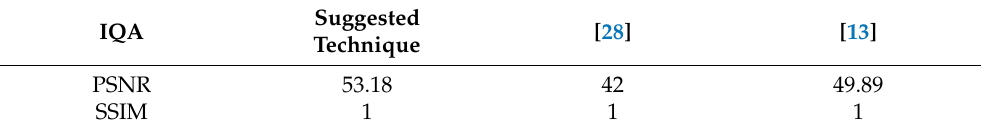
Table 5. Imperceptibility analysis.